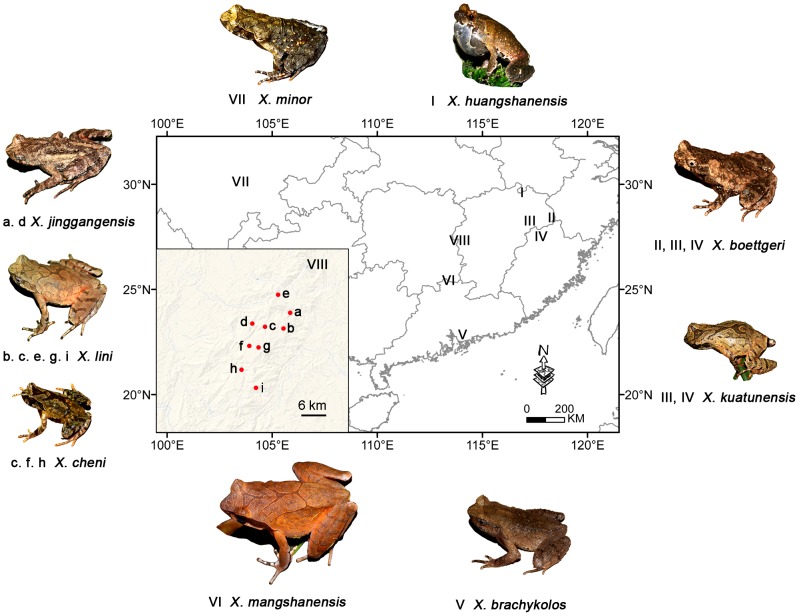
Sampling localities of Xenophrys toads in southern China.These include: I. Huangshan Mountains, here collected refer to X. huangshanensis from Mt. Dazhang, Wuyuan, Jiangxi; II. X. boettgeri from Mt. Tongbo, Jiangxi; III. X. boettgeri from Mt. Yangjifeng, Jiangxi; IV. X. kuatunensis from Guadun ( = Kuatun), Fujian; V. X. brachykolos from Hong Kong; VI. X. mangshanensis from Mt. Nanling, Guangdong; VII. X. minor from Mt. Emei and Mt. Laojun, Sichuan; VIII. the middle Luoxiao Mountains: X. jinggangensis from the peak of Mt. Jinggang, Jiangxi (a), and Taoyuandong, Hunan (d); Xenophrys lini
sp. nov. from Dabali (b) and Niushiping (g) in Hunan; Jingzhushan (c), Bamianshan (e), Nafengmian (i) in Jiangxi; Xenophrys cheni
sp. nov. from Jingzhushan (c), Jiangxi, Dayuan (f) and Lishuzhou (h) in Hunan.